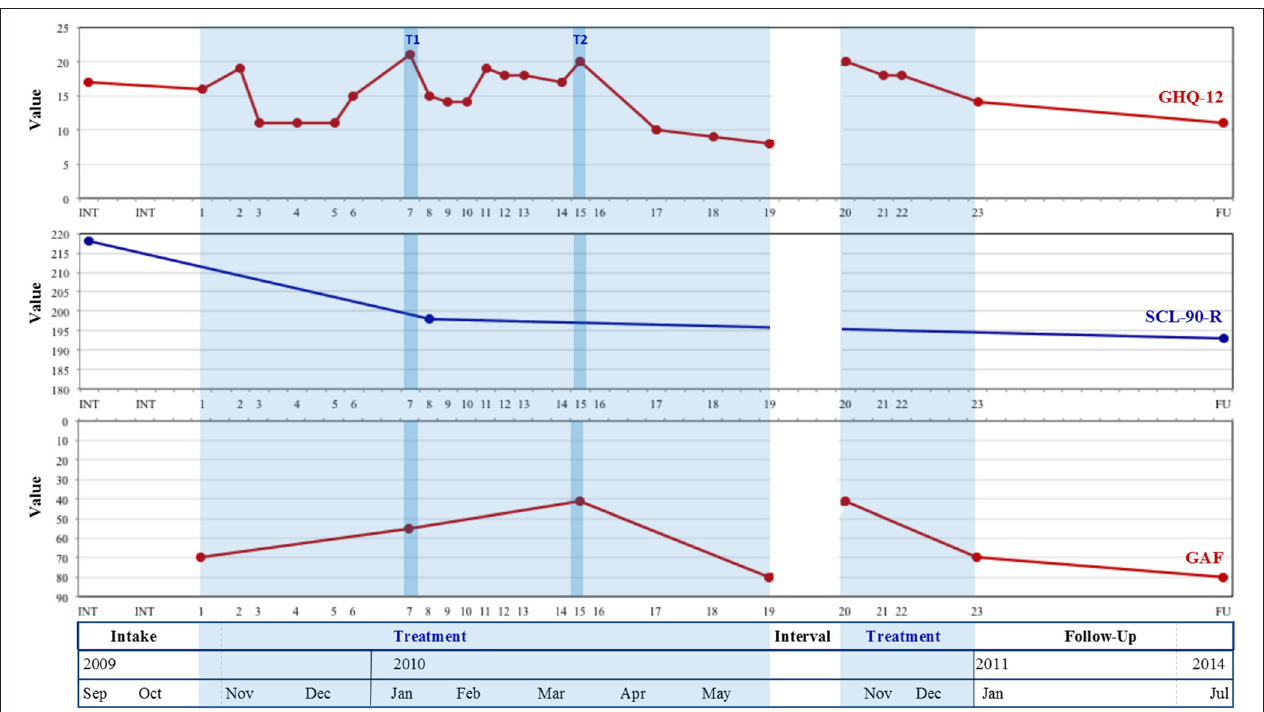
FIGURE 1 | Evolutions in patient-reported (GHQ-12, SCL-90) and researcher-rated (GAF) well-being from intake to follow-up. GHQ-12, General Health Questionnaire-12; SCL-90-R, Symptom Checklist-90-Revised; GAF, Global Assessment of Functioning; T1, Tipping point 1; T2, Tipping Point 2; Treatment was interrupted between sessions 19 and